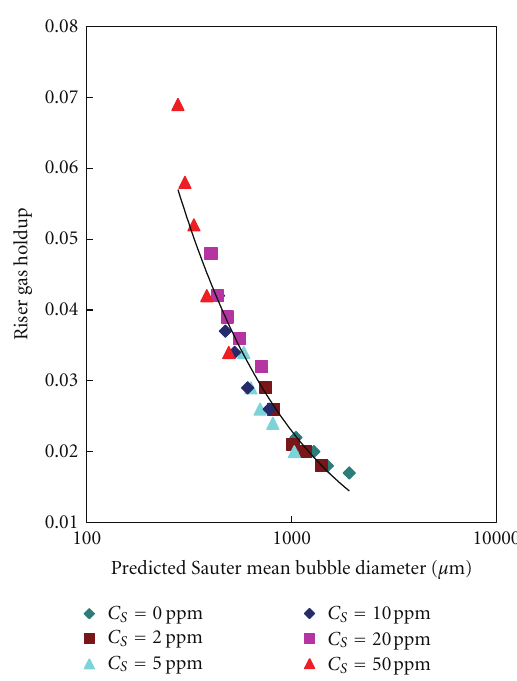
Figure 8: E ff ect of sparger design on gas holdup in the riser ( Δ P S = 280kPa).